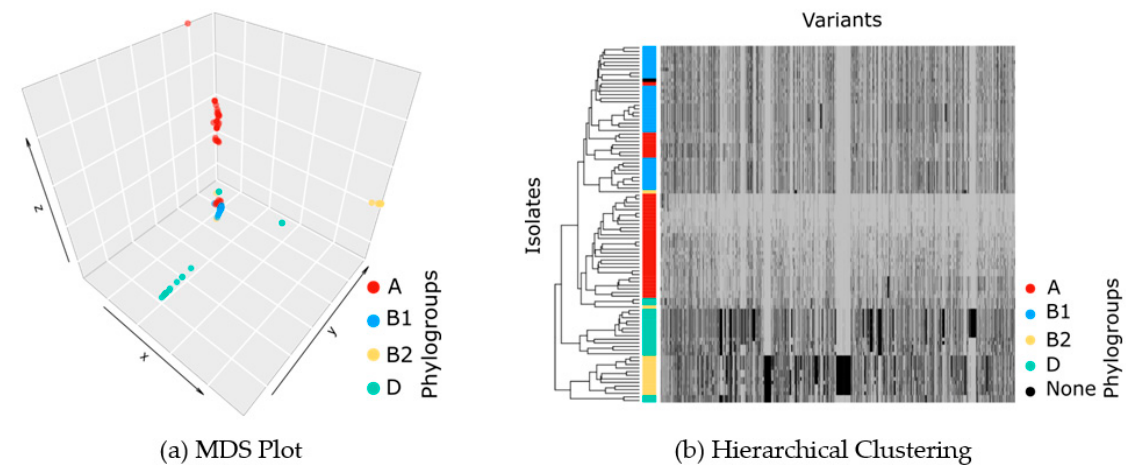
Figure 3. ( a ) Multidimensional scaling plot (MDS) on distances between isolates, calculated based on high-dimensional vectors of all mutations. Four clusters are found, which reflect the population structure in the GWAS model and which broadly coincide with phylogroups A, B1, B2, and D. ( b ) Hierarchical clustering on the vectors of presence/absence of variants for different isolates, where the presence of a variant is shown by black and its absence by gray.